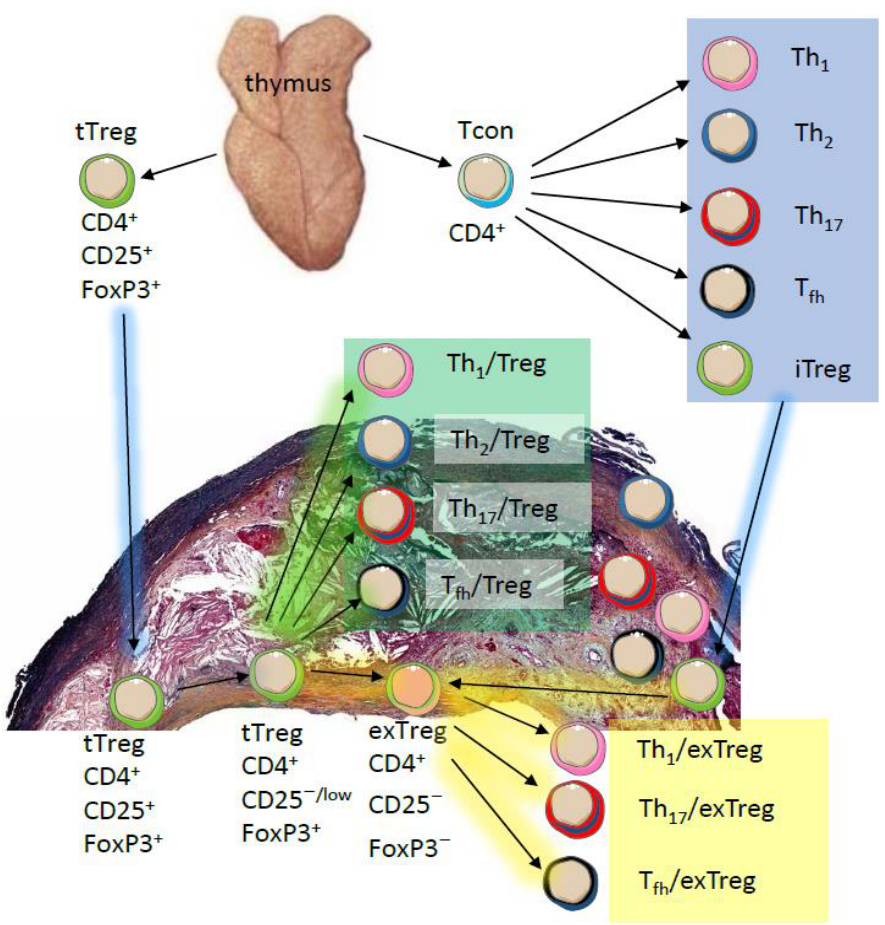
Figure 1. The thymus produces CD4 + CD25 + FoxP3 + tTregs (green), CD4 + conventional T cells (Tconv, blue) and many other cells (not shown). tTregs can migrate (blue arrows) into atherosclerotic lesions and the adventitia and maintain their phenotype. CD4 + Tconv differentiate into T-helper (Th)1, 2, and 17; T fh ; and induced iTregs. All of these (blue box) can also migrate into atherosclerotic lesions and the adventitia. In the lesion environment or in secondary lymphoid organs (not shown), both tTregs and iTregs can gain expression of T-bet for Th 1 , GATA3 for Th 2 , ROR γ t for Th 17 or Bcl6 for T fh , while maintaining expression of FoxP3 (Treg plasticity, green box). tTreg and iTregs can lose CD25 and FoxP3 expression and become exTregs that have a Th 1 , Th 17 , or T fh phenotype (Treg instability, yellow